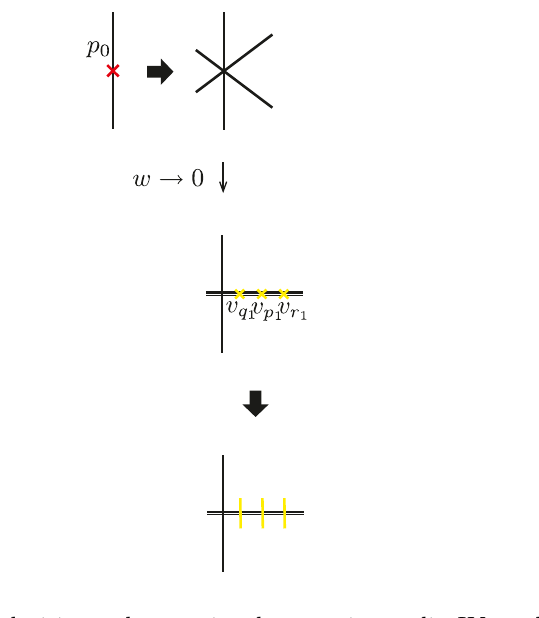
Figure 4 . Singularities and exceptional curves in a split IV